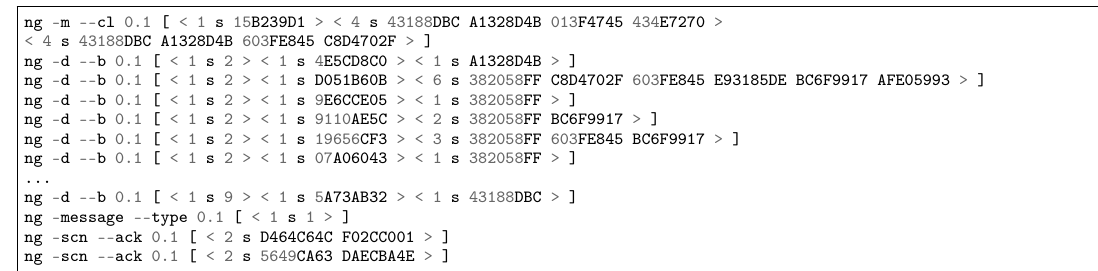
Figure 13. Log of the response from HTS to a RMS query about possible DSM peers.